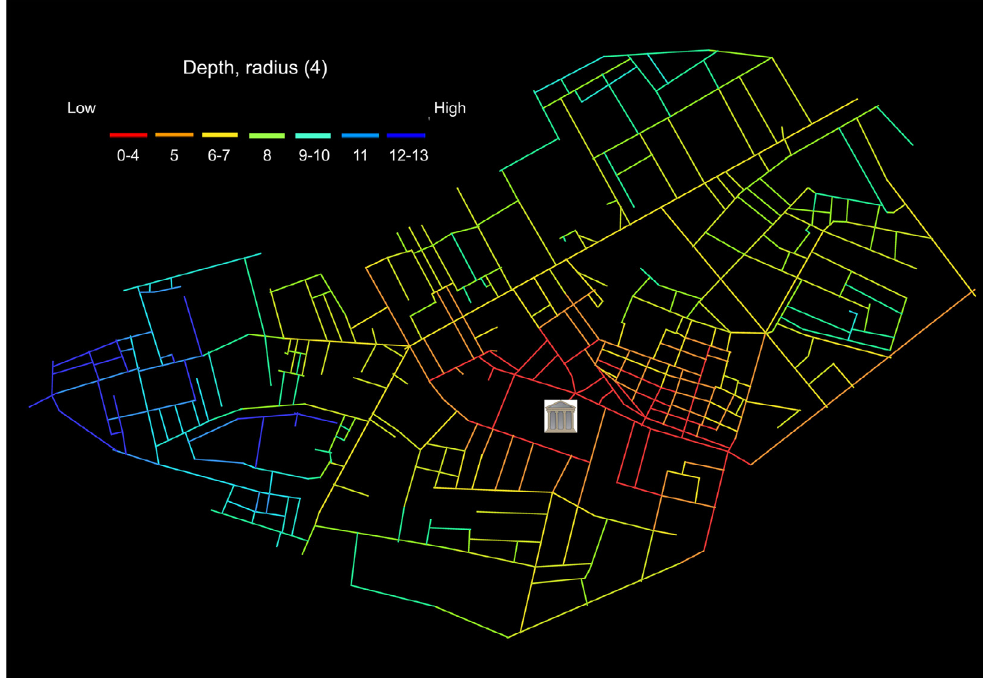
Figure 4. The Campo della Magna Mater on an axial graph, which shows the calculation of step depth 4 from the sanctuary. Streets shown in red are connected to the sanctuary by 4 or fewer street turns. Streets shown in blue have the highest depth, located the greatest number of street turn away from the